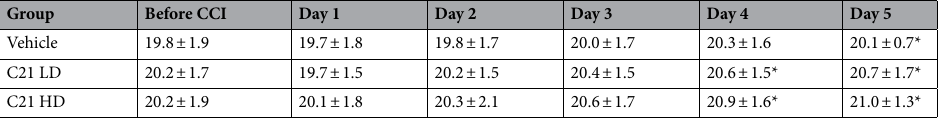
Table 3. Body weight in vehicle and C21 treated mice. Bodyweight of vehicle, low (LD C21) and high dose C21 (HD C21) treated mice before CCI and day 1 to 5 after CCI in g (* p < 0.05 vs. Day